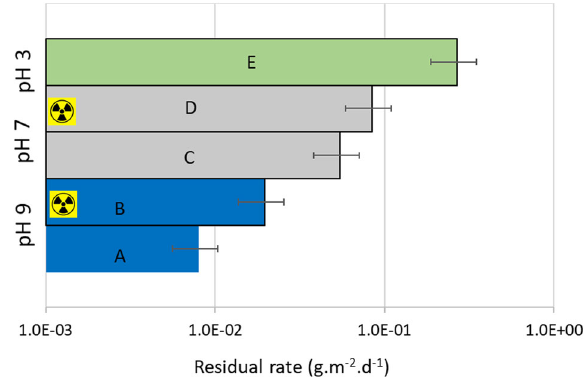
Fig. 10 Residual rates calculated from the release of B into the solution between 55 and 83 days for 5 of the 6 experiments. An uncertainty of 30% for the value of rr is taken. A, C, E correspond to non-irradiated samples, whereas B and D are related to pre- irradiated samples. Result for experiment F is not provided given that alteration went deeper than the irradiated depth.